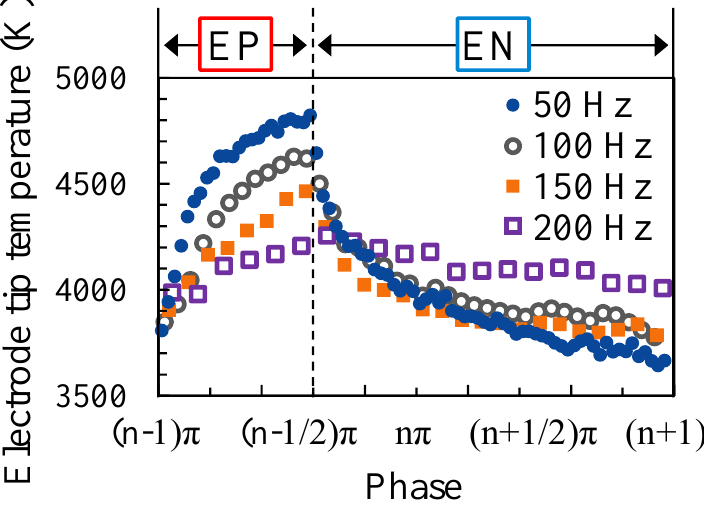
Figure 15. Temperature variation of the electrode tip for different AC frequencies.